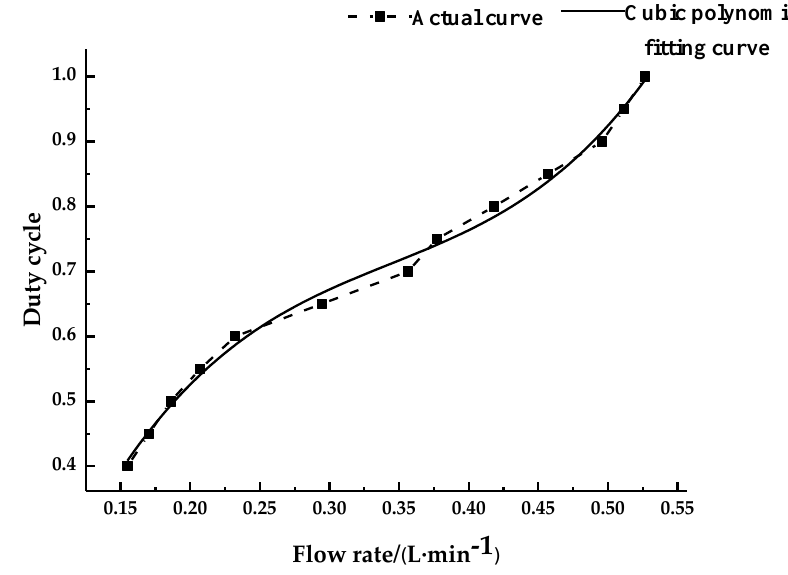
Figure 8. Velocity curve of the miniature diaphragm pump.